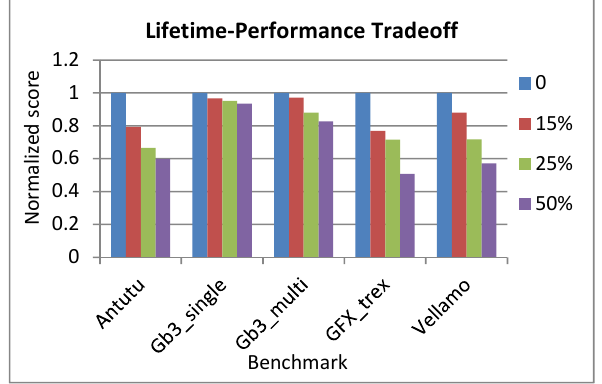
Figure 9. Benchmark evaluation of battery lifetime and performance tradeoff